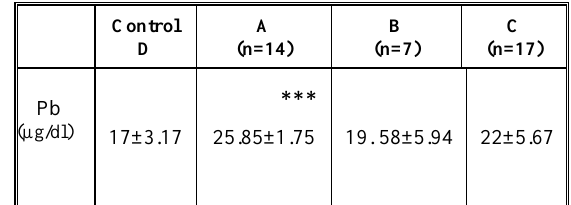
Table (4): Comparison of blood lead levels among children groups.